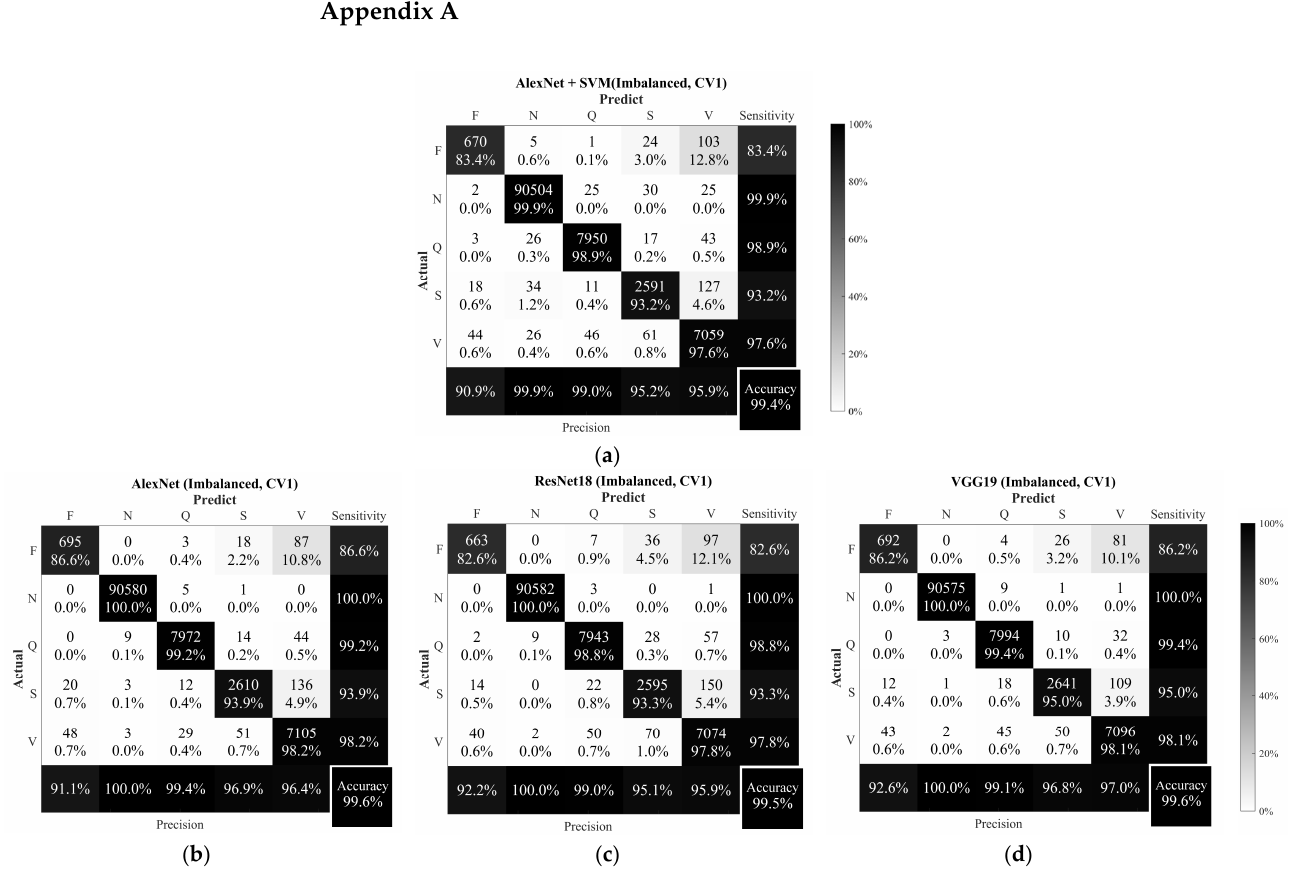
Figure A1. Confusion matrix of ( a ) AlexNet + SVM, ( b ) AlexNet, ( c ) ResNet18, and ( d ) VGG19 for the CV1 (imbalanced